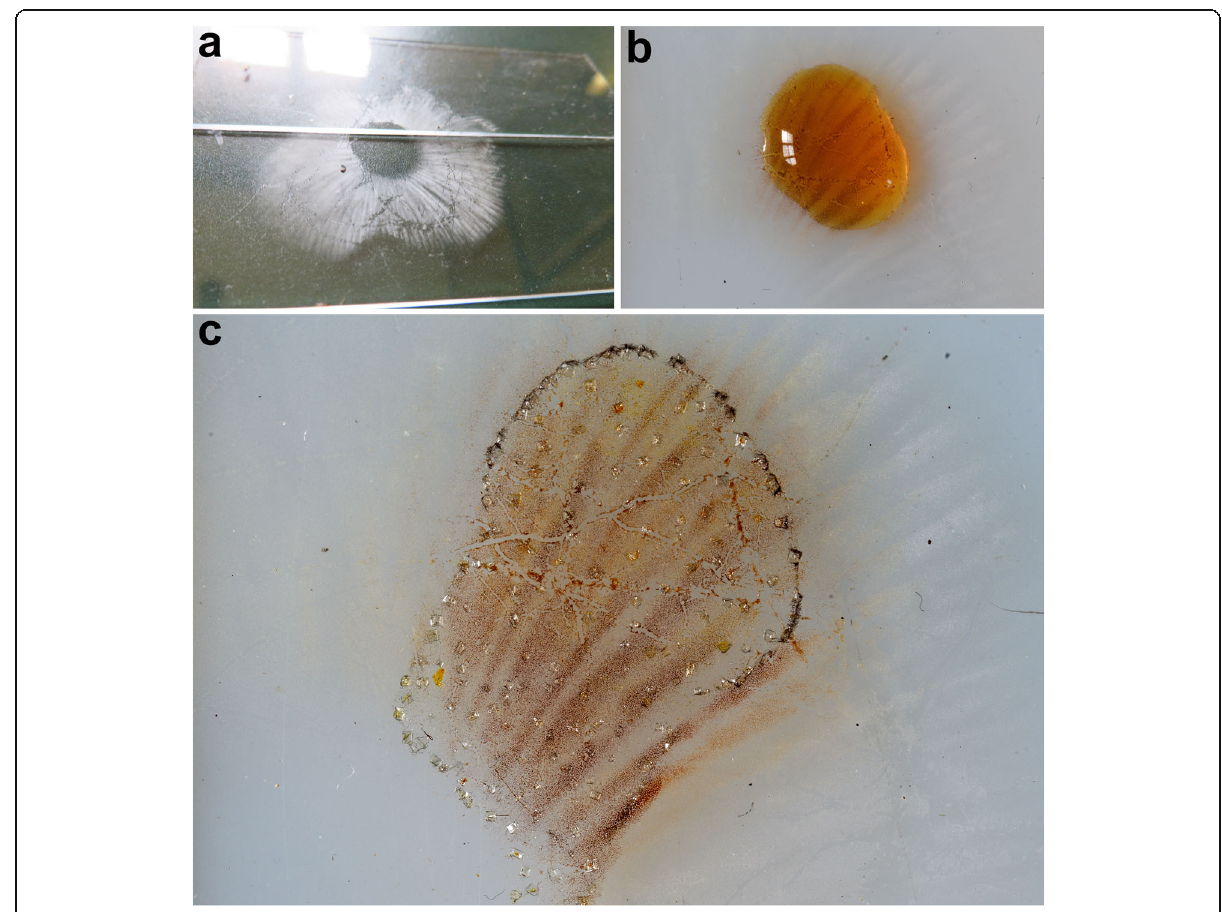
Fig. 8 Tricholoma josserandii (TO AV260920). a . Spore print on microscope slides. b . Drop of Melzer ’ s placed on part of the spore print. c Part